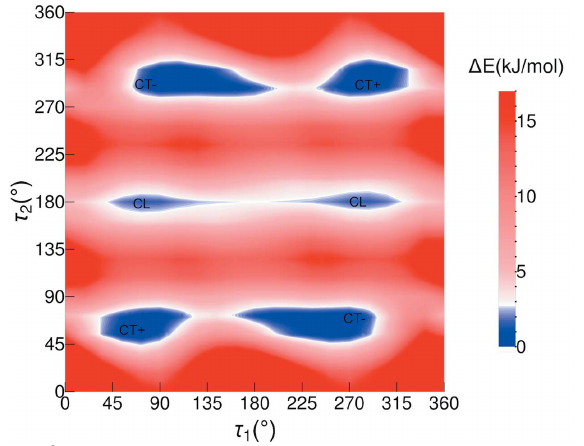
Figure 5 Relative conformational energies, geometries and visualization of the three symmetrically independent minima located in the PES (B97d/6-